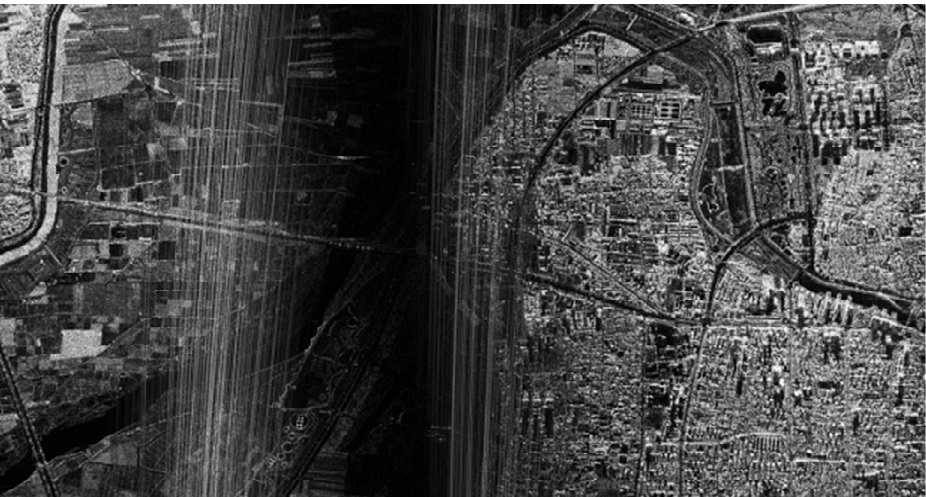
Figure 18. SAR image after DCC with IPSR error of 18°.